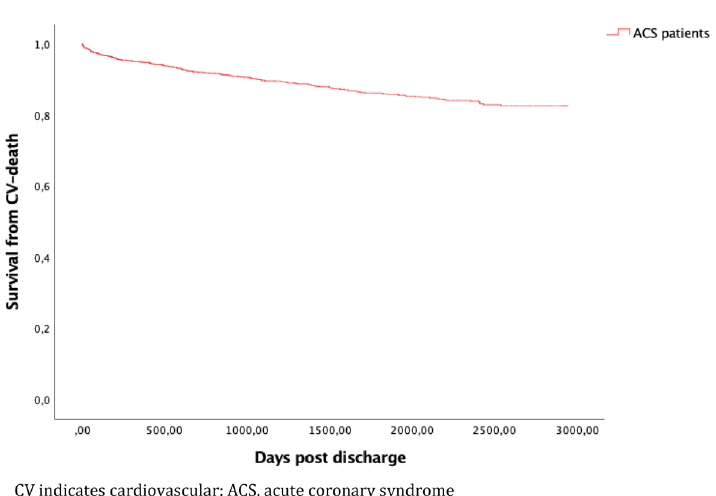
Figure 3. Cumulative Kaplan–Meier estimate of CV-death free survival among 1379 patients discharged after hospitalization for ACS between 1 Jan 2010 and 31 Dec